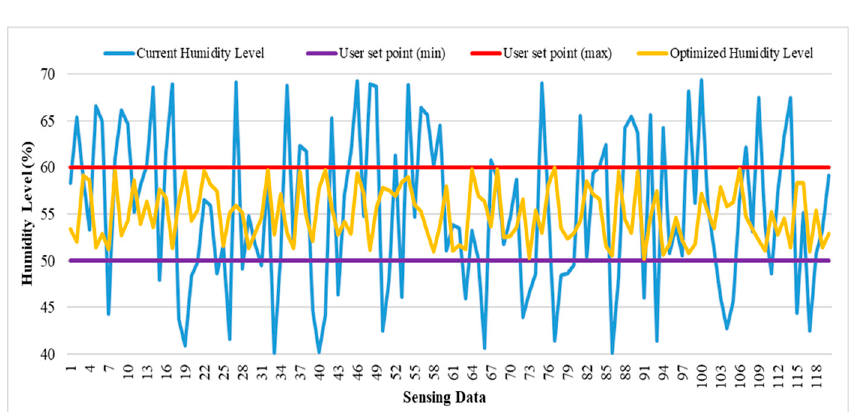
Figure 13. Optimization scheme results for the humidity